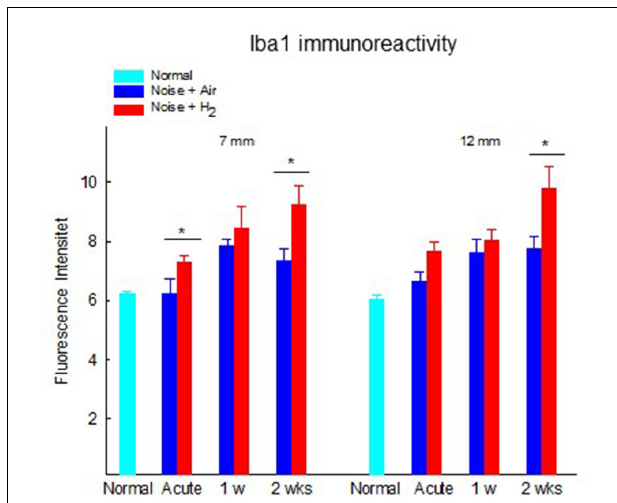
FIGURE 8 | Quantification of the immunoreactivity of Iba1 in the stria vascularis area. The measurements were performed at 2 points corresponding to 7 and 12 mm from the RW. Data are presented as mean + SEM. * p <